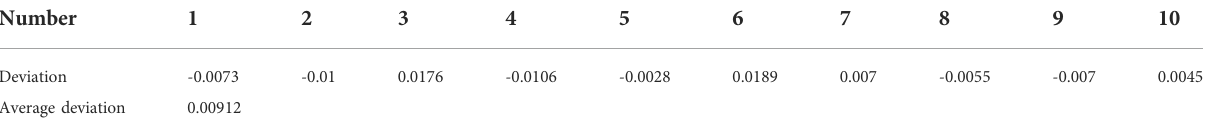
TABLE 5 Plane fi t test result (mm).